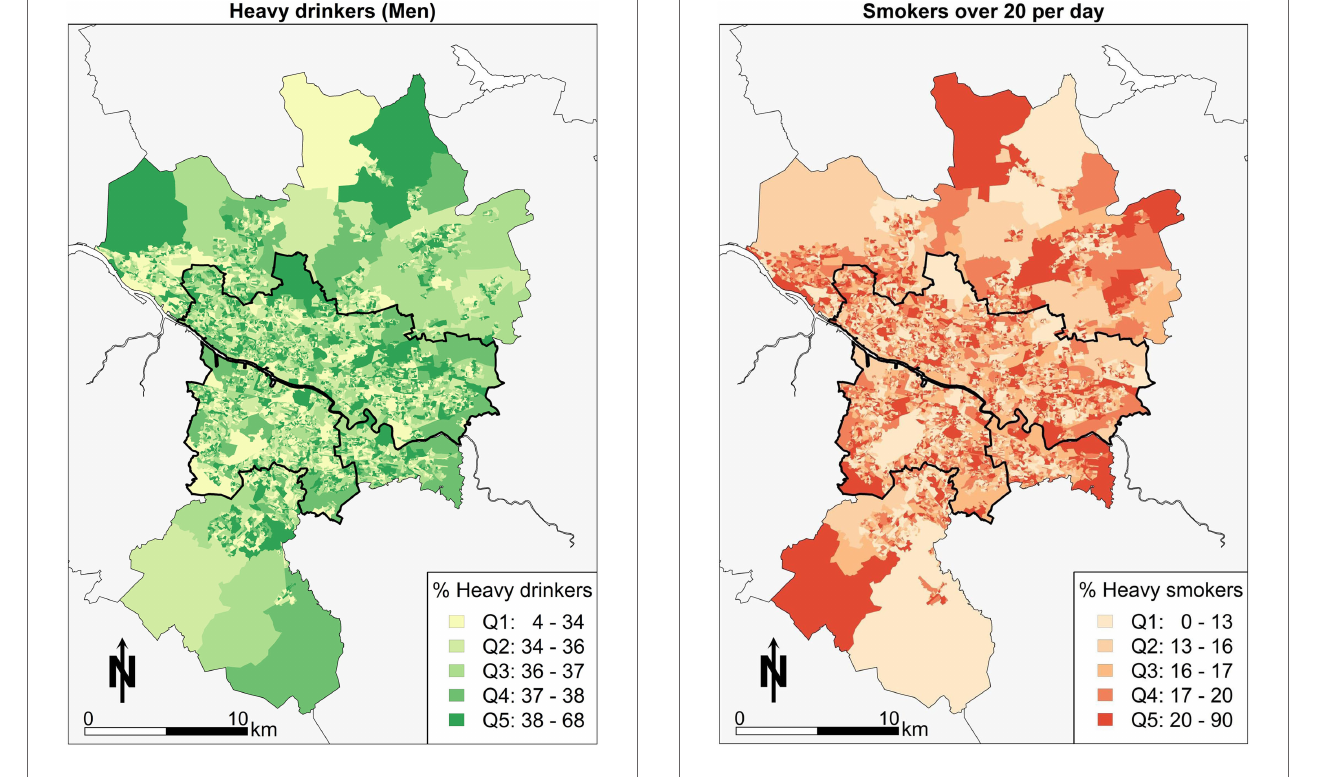
FigUre 4 | alcohol consumption over daily limit (men) . FigUre 5 | heavy smokers